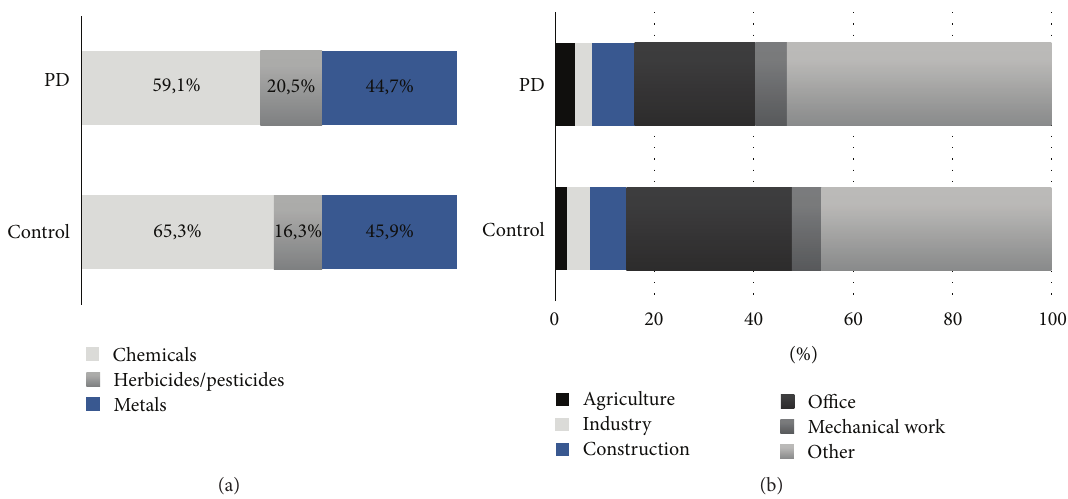
Figure 2: (a) Distribution of types of toxicants handled by the two groups. (b) Distribution of occupational categories in the two groups.